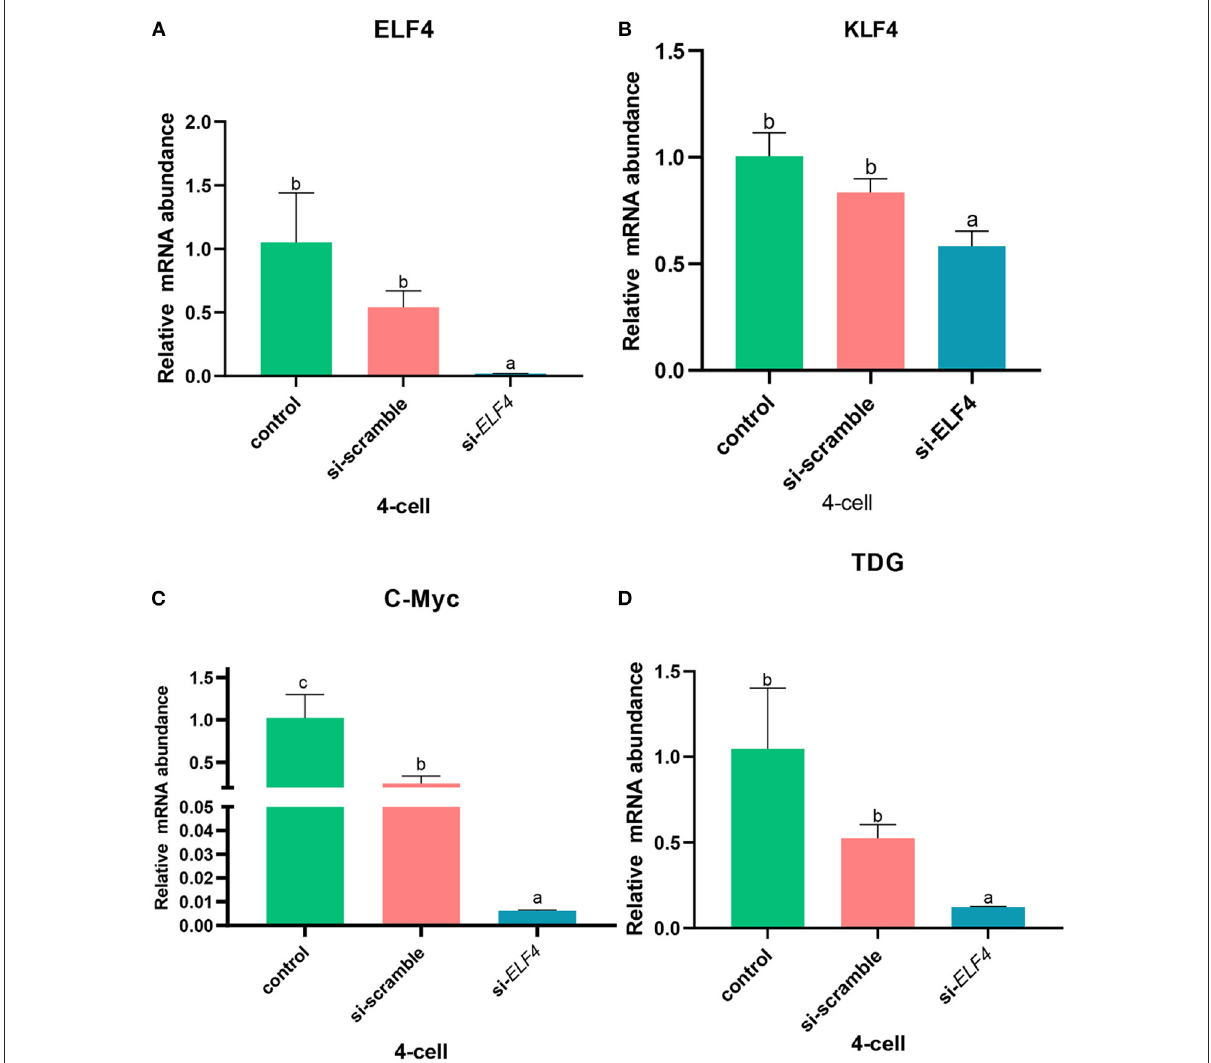
FIGURE8 Knockdown of ELF4 affected ZGA-related genes initiation in porcine embryos. (A) Transcriptional levels of ELF4 . (B–D) Transcriptional levels of ZGA-related genes KLF4 (B) , C-Myc (C) and TDG (D) in the control, si-scramble and si- ELF4 embryos. Different lowercase letters indicate statistical differences ( p <